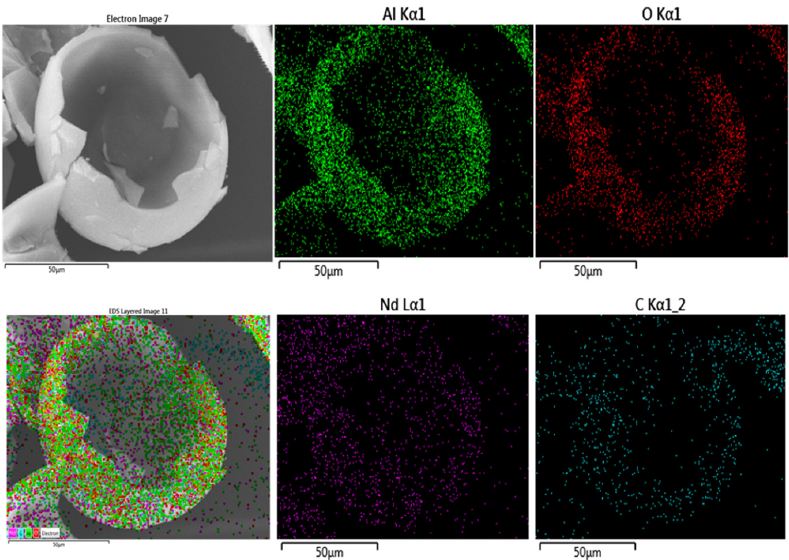
Figure 6. SEM mapping image by element of the Al-Nd-25 binary oxide.